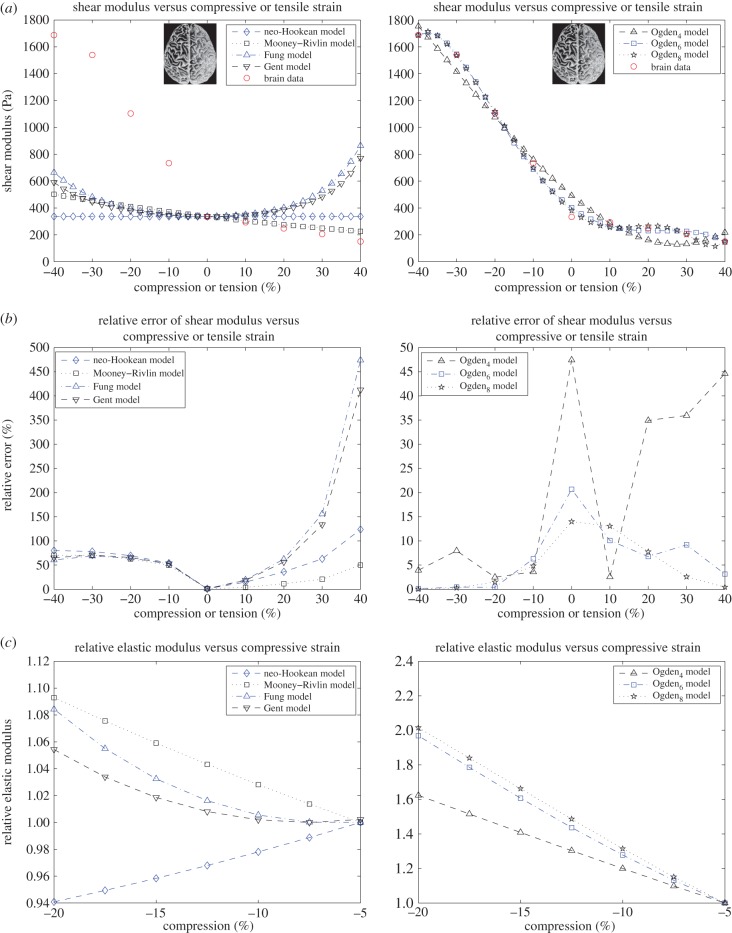
Brain data and models fit. Left: neo-Hookean, Mooney–Rivlin, Fung and Gent models. Right: Ogden4, Ogden6, Ogden8 models. (a) Shear modulus μ compared with experimental data for brain tissue at 2% shear superposed on up to 40% compression or tension; (b) the associated relative errors and (c) the elastic modulus E normalized to its value at 5% compression.